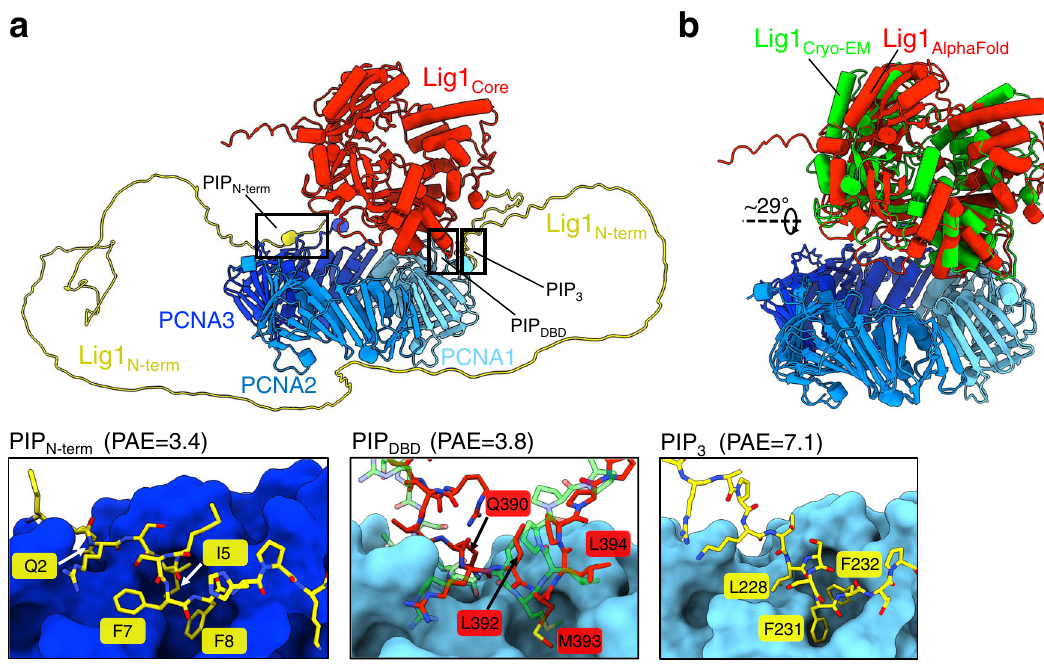
Fig. 2 | AlphaFold prediction of the Lig1 – PCNA complex. a First ranked model showing the Lig1 N-terminal region (residues 1-263) and Lig1 Core (residues 264- 919) as yellow and red ribbons, respectively, and PCNA trimer as ribbons in dif- ferentshadesofblue.Theinsetsshowclose-upsofthethreepredictedbindingsites and associatedaligned error (PAE), withLig1residues shown assticks and PCNAas surface. The middle panel shows an overlay of the predicted PIP DBD interface (red